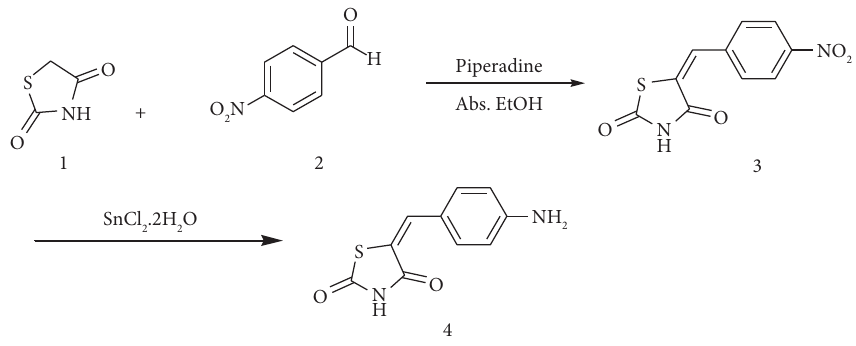
Scheme 1: Synthesis of amine